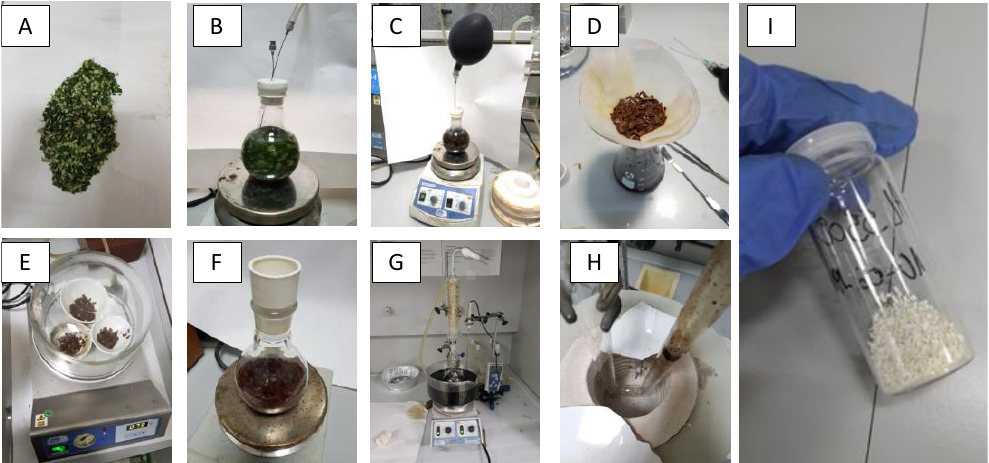
Figure 1. Pictures taken at different steps during the synthesis of AOL. ( A ) Fresh olive leaves cut and washed. ( B ) Acid hydrolysis under N 2 atmosphere. ( C ) Addition of TiCl 3 under N 2 atmosphere. ( D ) Filtering and washing. ( E ) Drying at 120 °C. ( F ) Suspension of leaves in isopropanol and titanium isopropoxide. ( G ) Reflux at 80 °C, 6 h. ( H ) Calcination at 550 °C. ( I ) Resulting AOL.